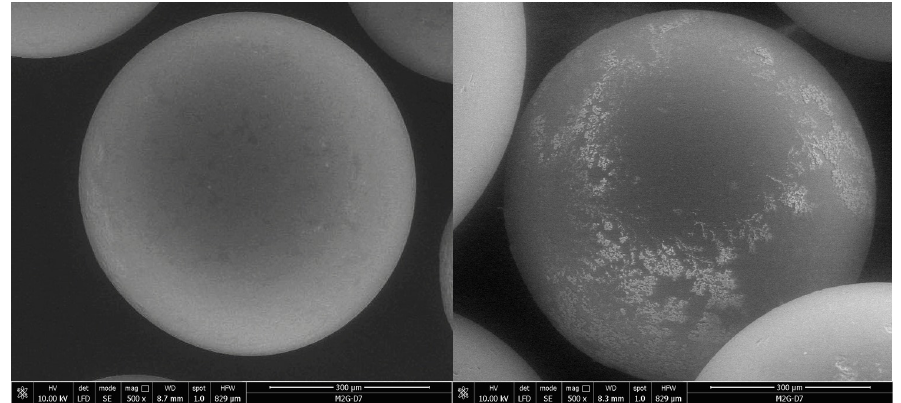
Figure 2. Scanning electron microscopy (SEM) for XAD 7-AcG material: ( a ) before impregnation; ( b ) after impregnation.